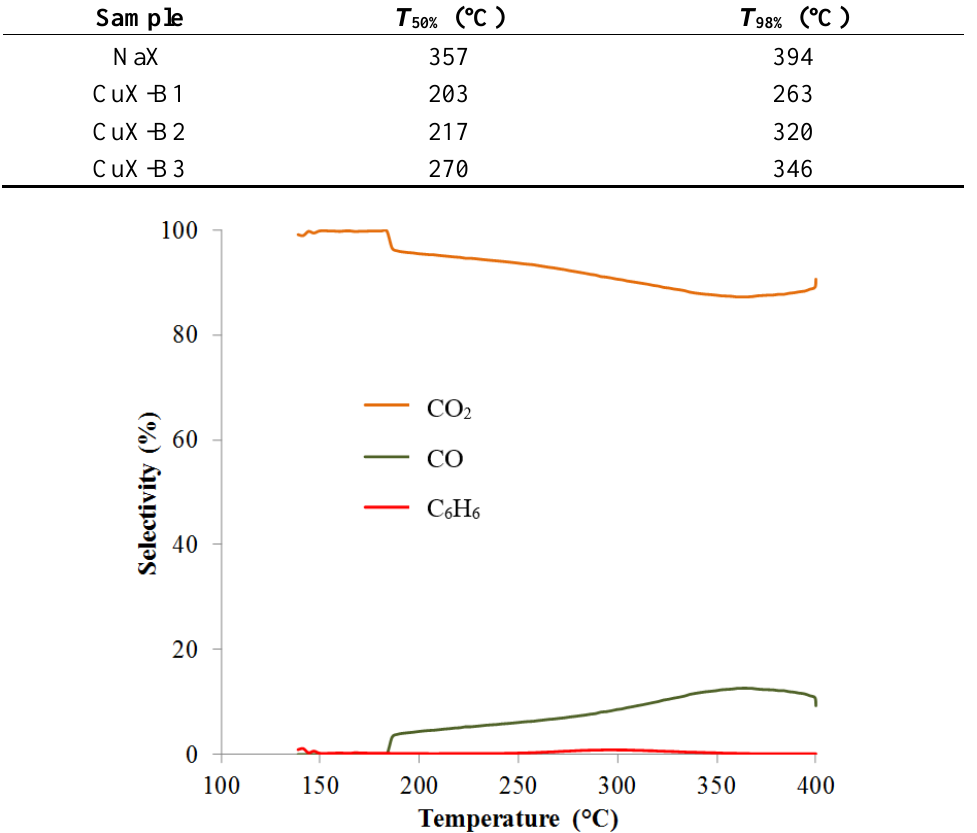
Figure 9. Variation of CO 2 , CO and benzene selectivities (%) with the reaction temperature over CuX-B1